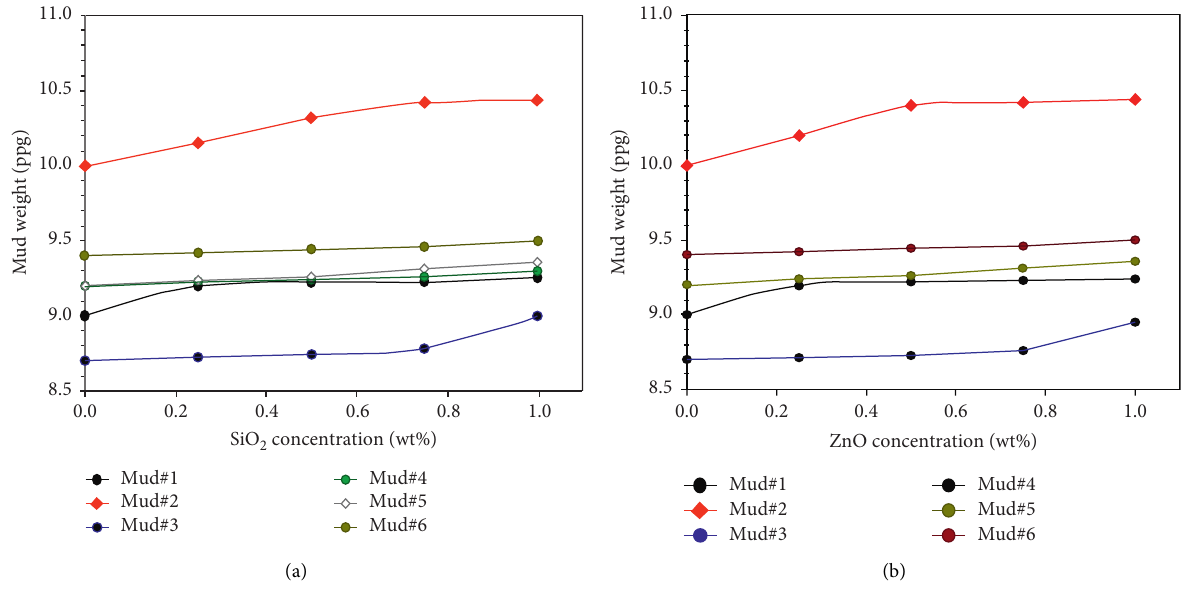
Figure 7: Density of drilling muds (a) with and without SiO